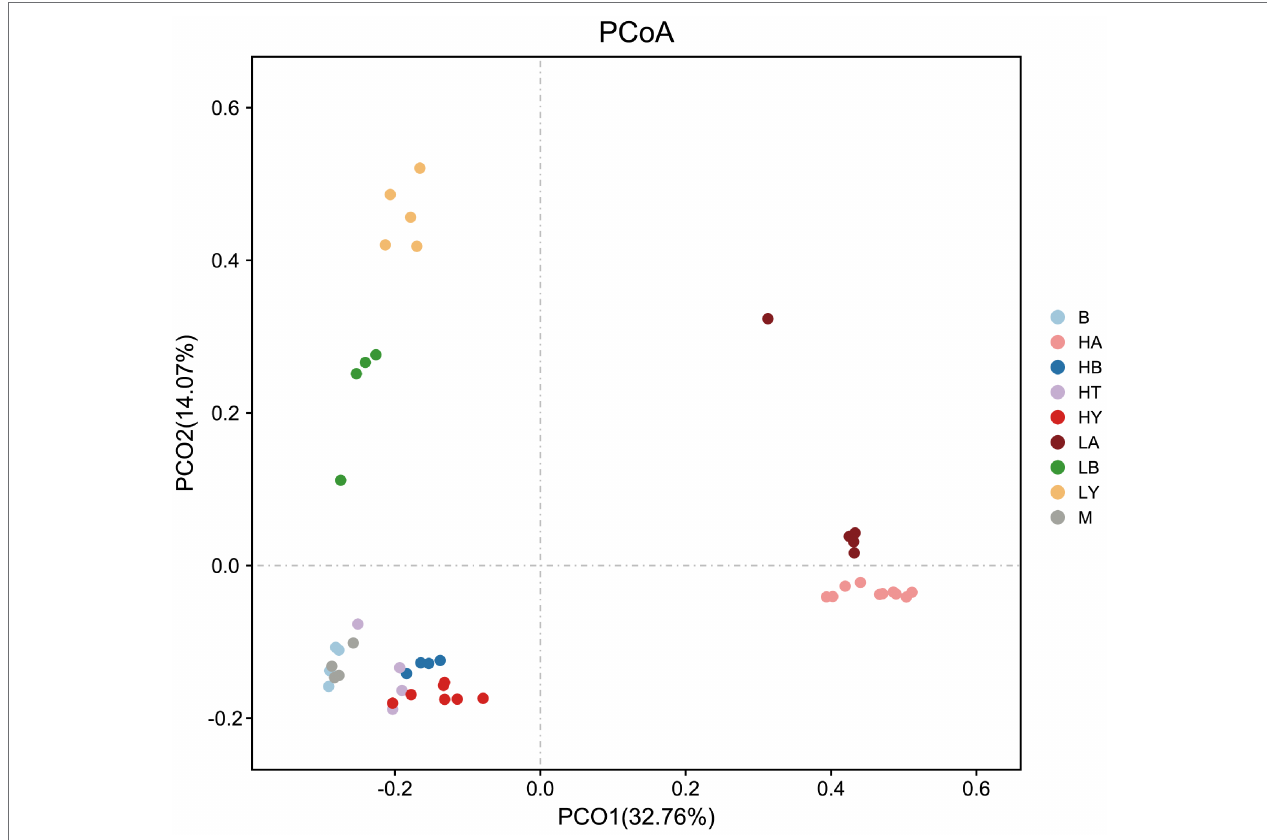
FIGURE 3 | Principal coordinates analysis (PCoA) of gut microbiome composition. Each symbol represents the gut microbiome of a group. HA, high-altitude Tibetan wild ass; HB, high-altitude blue sheep; HT, high-altitude Tibetan antelope; HY, high-altitude yak; LA, low-altitude Tibetan wild ass; LB, low-altitude blue sheep; LY, low-altitude yak. B, blue sheep from Xining wildlife zoo, M, European Mouflon from Xining wildlife